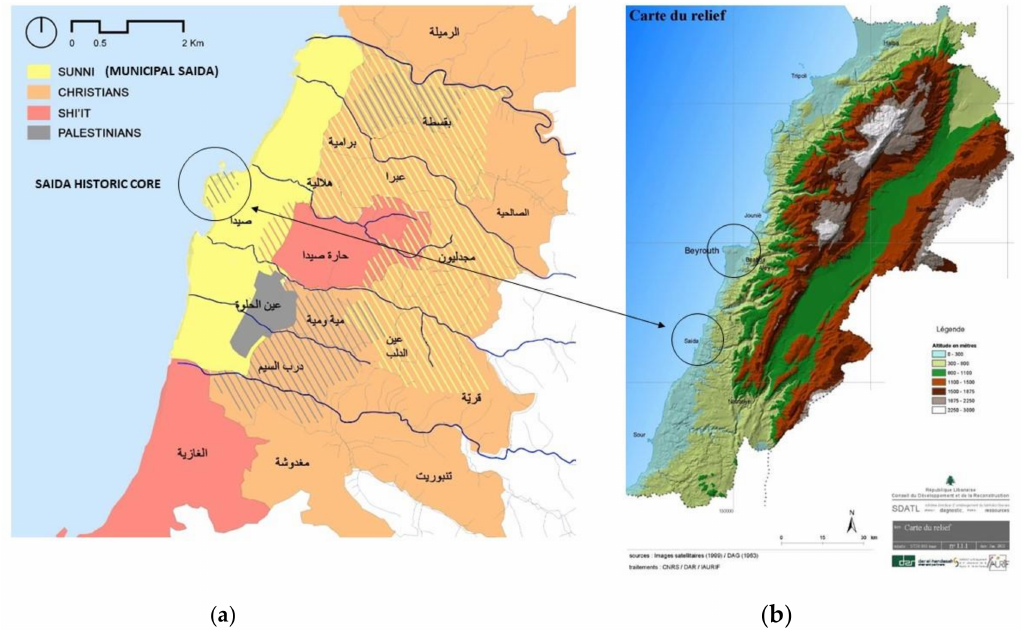
Figure 1. ( a ) Saida, religious composition (source: authors) and ( b ) the location south of the capital of Lebanon, Beirut